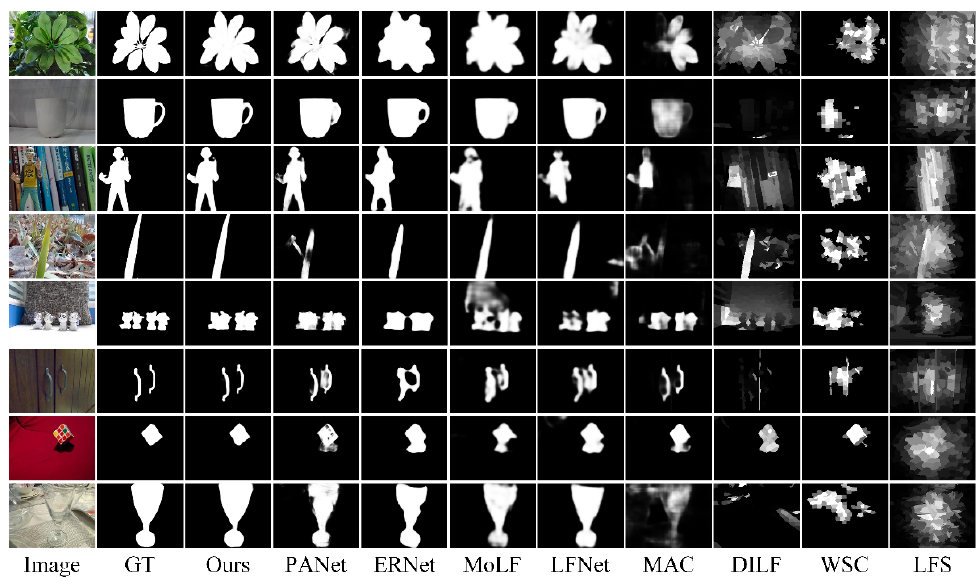
Figure 5. Qualitative comparison with the state-of-the-art methods.